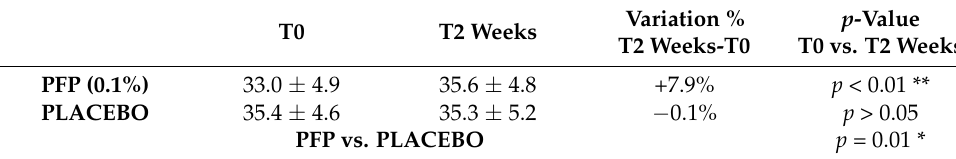
Figure 11. Observational analysis of deep hydration, elasticity and extensibility parameters of vaginal area of 30 female volunteers at starting time (T0) and after two weeks (T2) of treatment with PFP 0.1%-containing, or placebo, cream and mask. Data are expressed as the total score assigned following gynecologist evaluation. Table 1. Score values obtained by deep hydration examination of active PFP-treated or placebo groups. Averages, standard deviations, variations and statistical significance ( p -value) for each group and between groups are reported. * p < 0.05, ** p < 0.01.